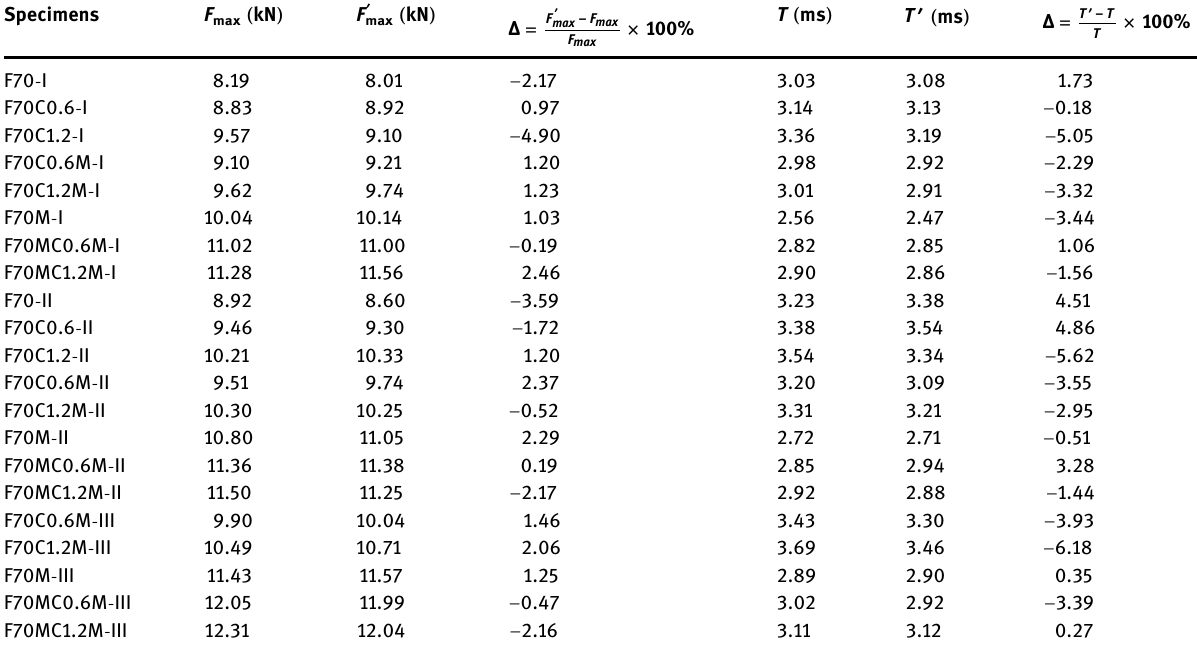
Table 8: Comparisons of the peak - impact forces and duration of syntactic foam panels between the numerical and experimental results